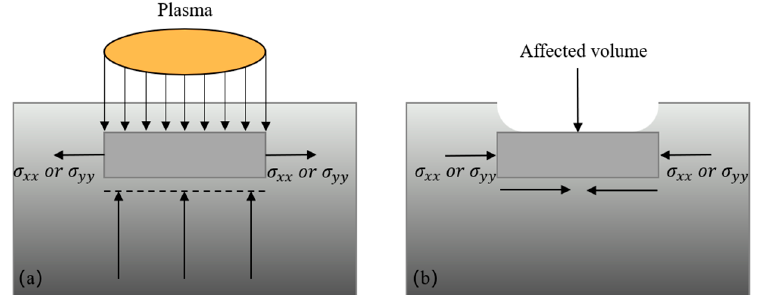
Figure 3. Schematic diagram of the residual compressive stress under laser shock ( a ) Laser shock process ( b ) After the laser shock.